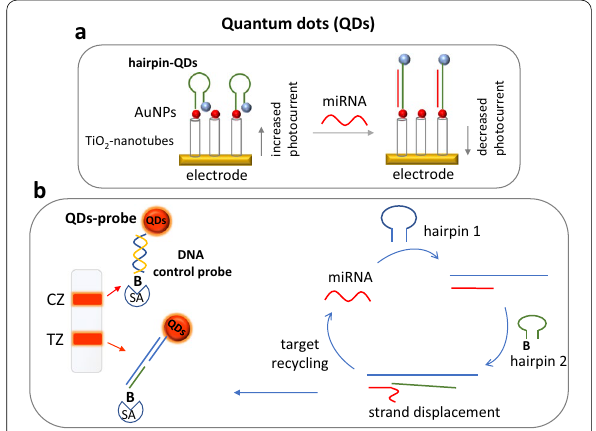
Fig. 4 a A photoelectrochemical sensing system based on a decrease in the signal, as quantum dots (QDs) are moving away from the electrode’s surface upon hybridization of target miRNA to DNA hairpin/AuNPs/TiO 2 NPs-decorated fluorine-tin oxide electrodes. b A lateral flow assay based on QDs-DNA as reporters and SDA target amplification for miRNA detection. AuNPs gold nanoparticles, TZ test zone, CZ control zone, SA streptavidin, B